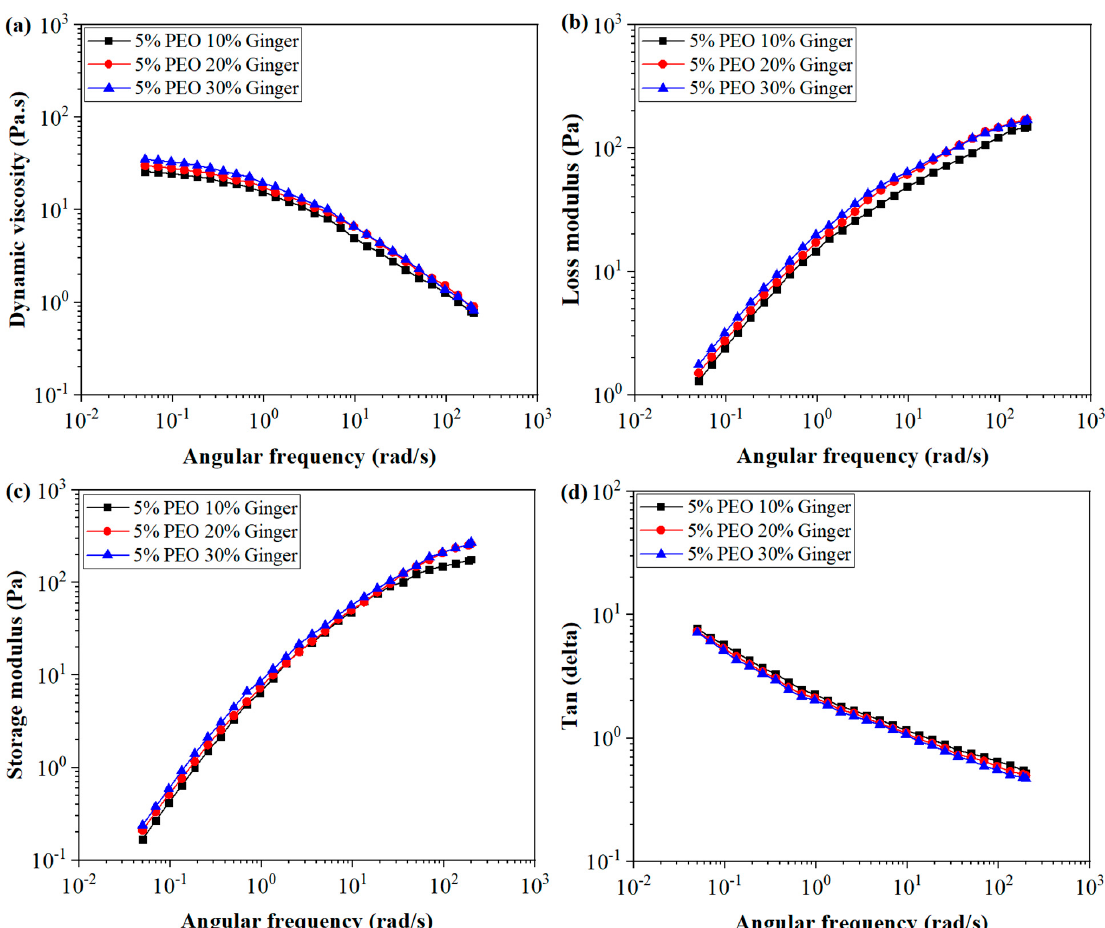
Figure 6. Dynamic viscosity, loss modulus, storage modulus, and tangent delta of PEO/GE nanofibres (PEO 5% GE 10%, 20%, 30% ).